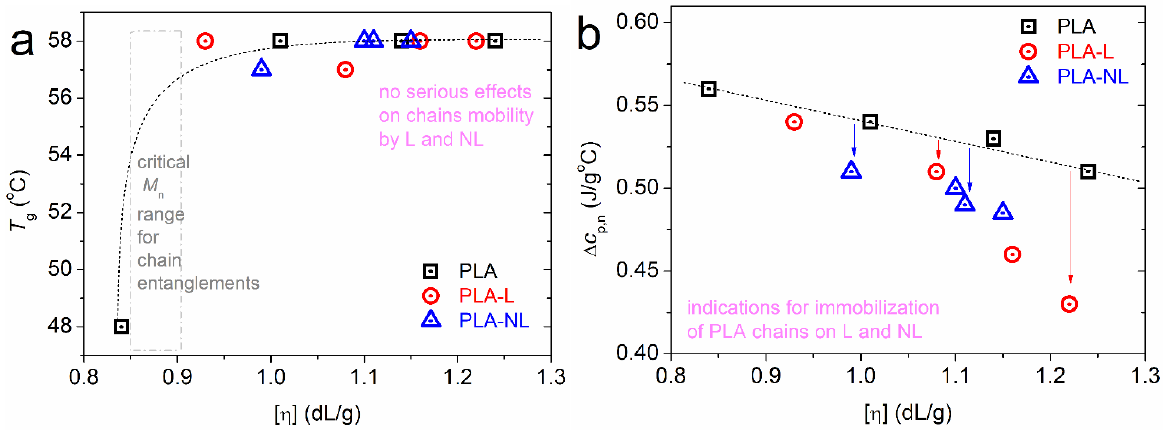
Figure 4. The [η] dependence on ( a ) glass transition temperature and ( b ) normalized heat capacity change. The lines connecting the experimental points were added to guide the eye.